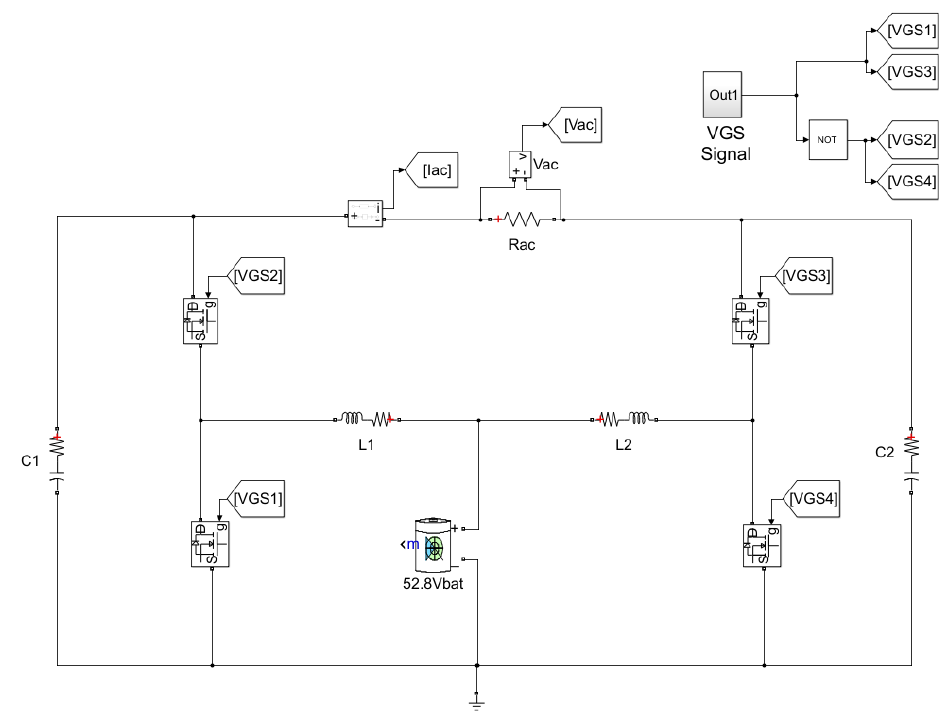
Figure 14. The circuit diagram of the proposed inverter in the simulation.